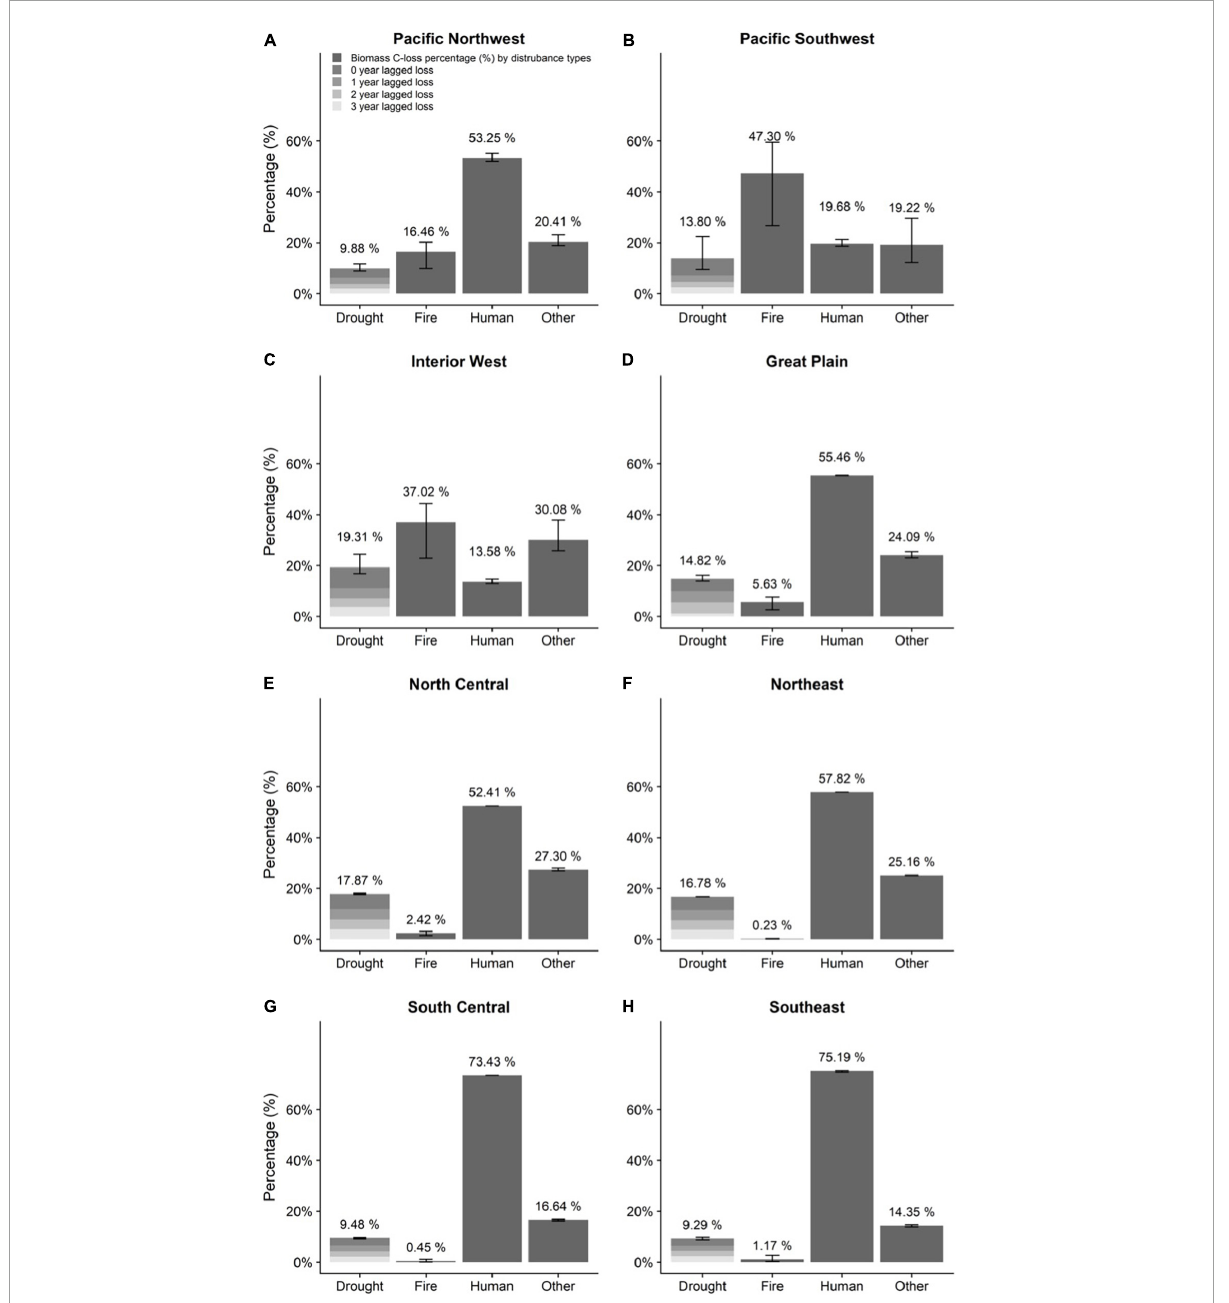
FIGURE6 Variation in potential aboveground carbon loss/transfer for canopy trees in the eight forest service sub-regions in CONUS for 2000–2014. (A) Pacific Northwest. (B) Pacific Southwest. (C) Interior West. (D) Great Plains. (E) North Central. (F) Northeast. (G) South Central. (H) Southeast. Numbers over the gray bars are the percentage of loss/transfer for each of the major disturbances, including fire, anthropogenic (especially timber harvest), drought-associated, and others. Error bars indicate the range of lower to upper estimates for each category.